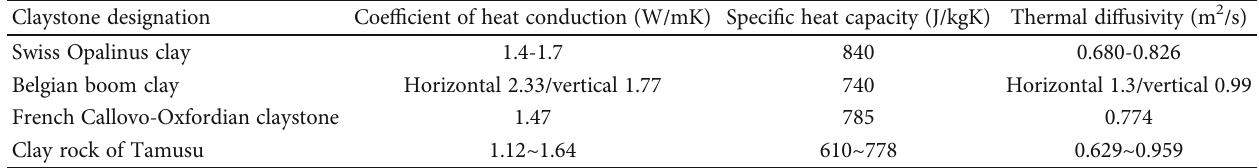
Table 3: Comparison of thermal conductivity parameters between Tamusu clay rock and other clay rocks [19 – 22]. Claystone designation